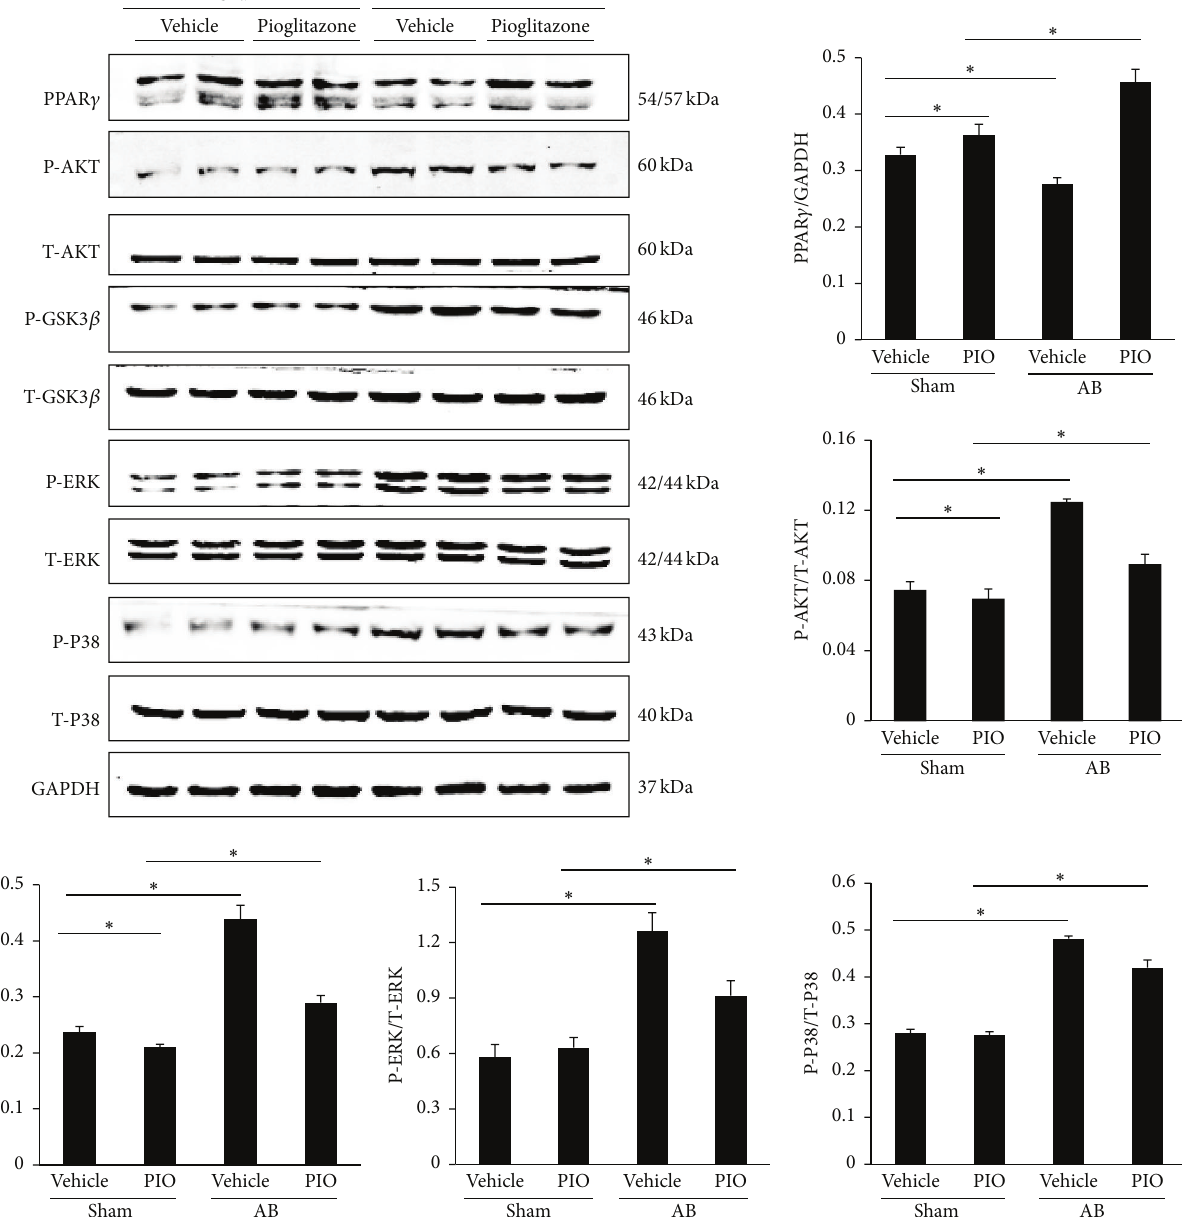
Figure 3: PIO protects against cardiac hypertrophy by inhibition of MAPK and AKT/GSK3 𝛽 pathways. Representative and quantitative expression of PPAR 𝛾 , phosphorylated AKT, GSK3 𝛽 , ERK, P38, and the effects of PIO in group of AB or sham with or without PIO ( 𝑛 = 6 ). ∗ 𝑃 < 0.05